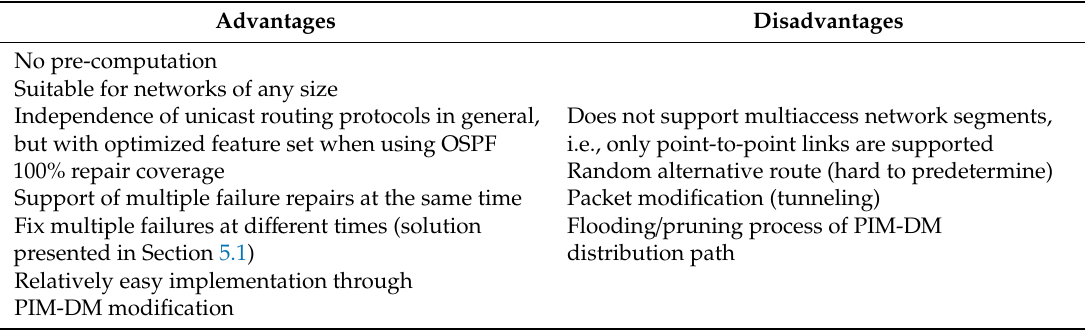
Table 6. Features of M-REP mechanism.